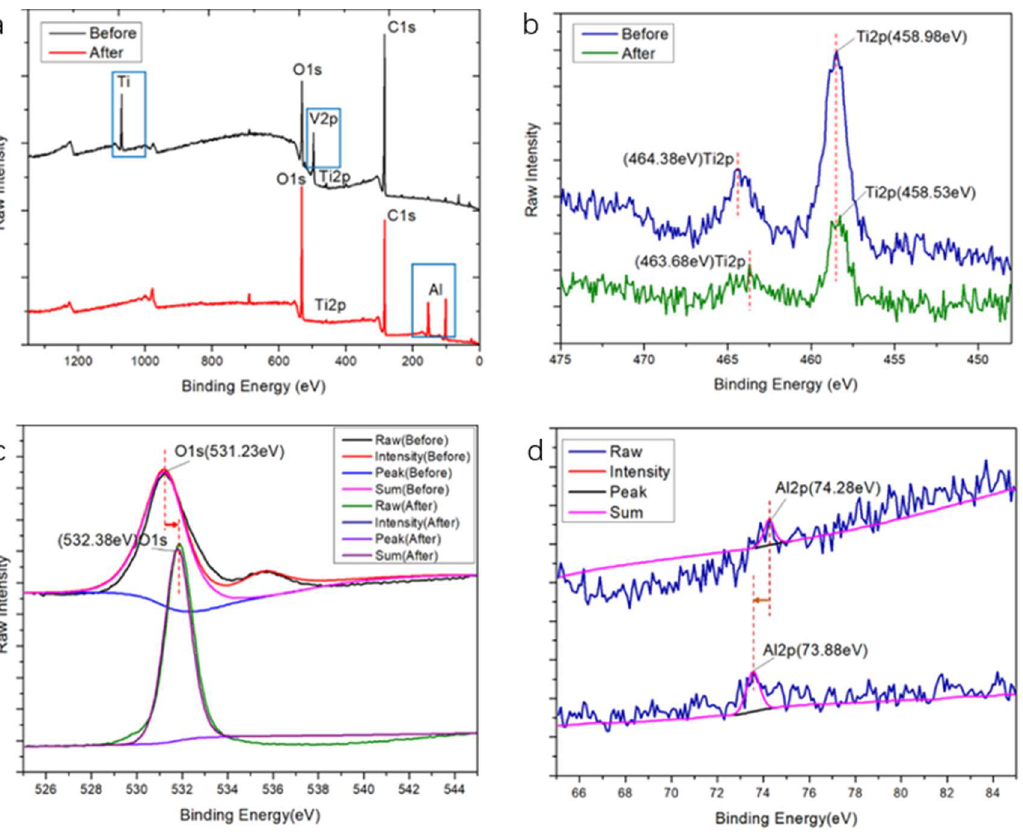
Figure 2. XPS patterns of the samples with different bionic microtopography coatings. Notes: ( a ) survey XPS spectrum; ( b ) Ti2p XPS spectrum; ( c ) O1s XPS spectrum; ( d ) Al2p XPS spectrum.